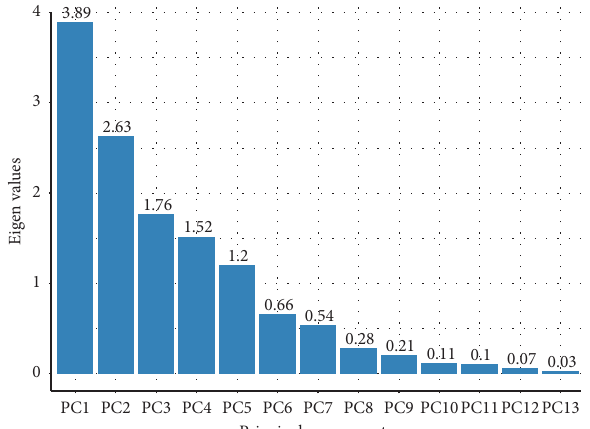
Figure 1: Eigenvalues of different principal components as shown by principal component analysis of rice